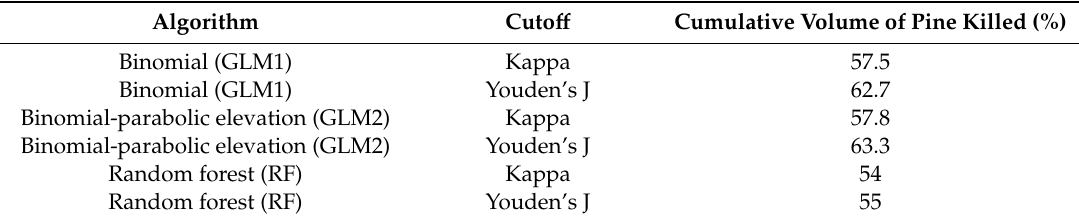
Table 3. Estimates of cumulative percentages of pine volume killed in MPB attacks by 2014 for three algorithms.